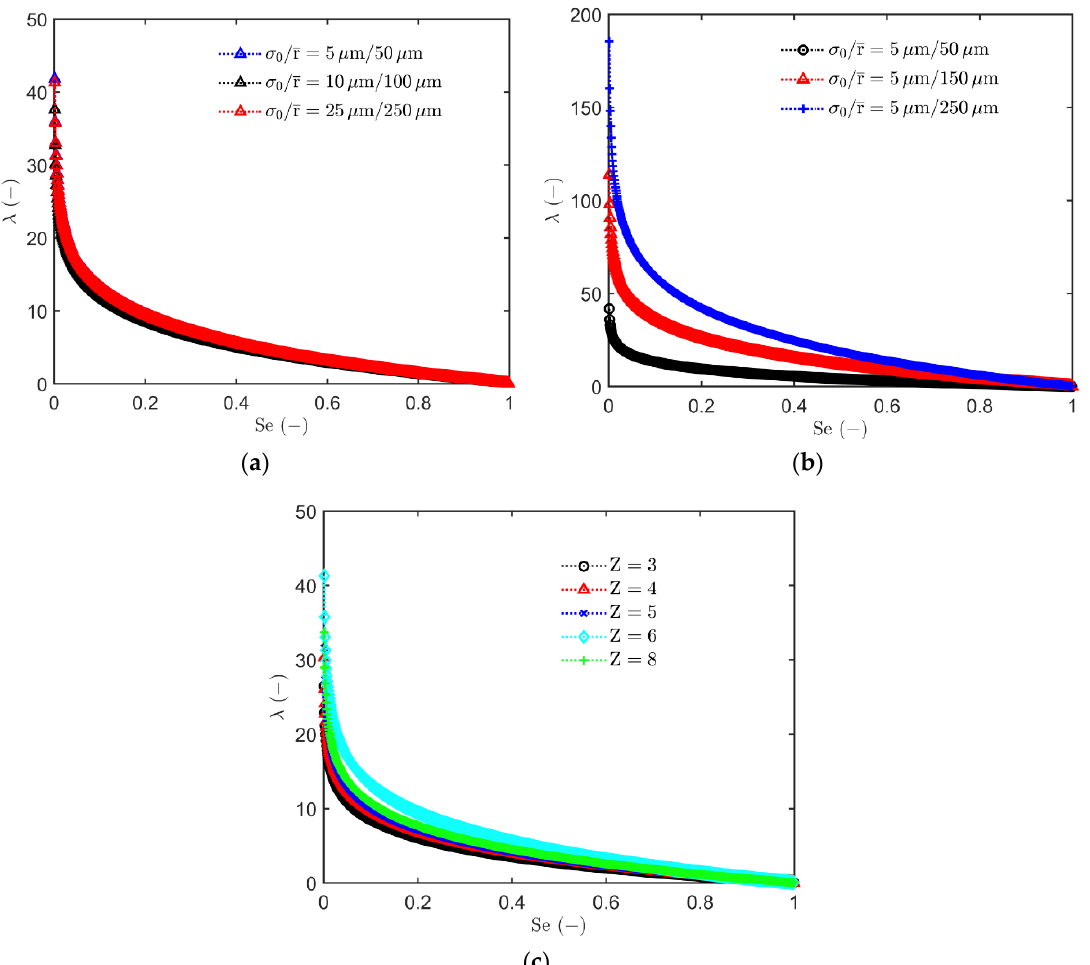
= 25 / 250 ( µ m). The values are 0 / r